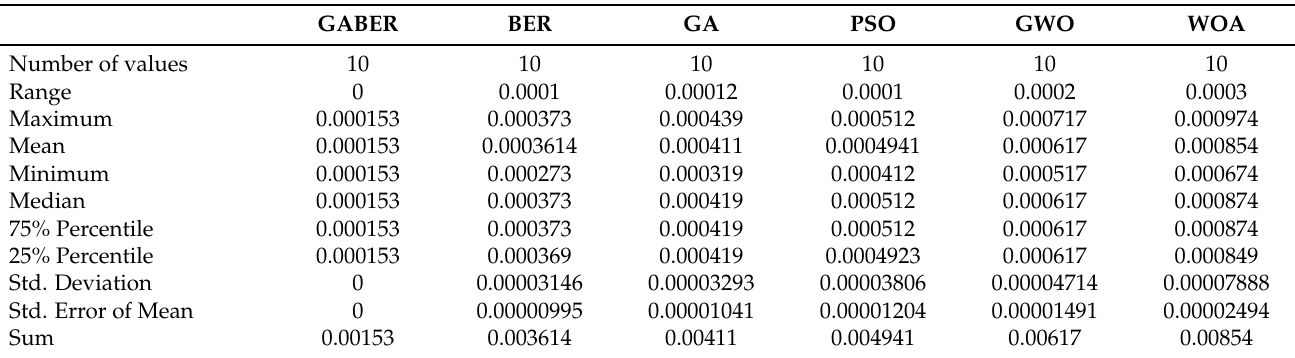
Table 16. Statistical analysis of the prediction results achieved by the proposed optimized ensemble model when applied to the solar radiation